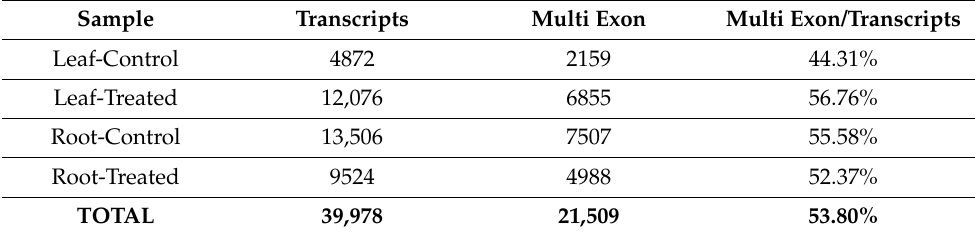
Table 2. Assembly